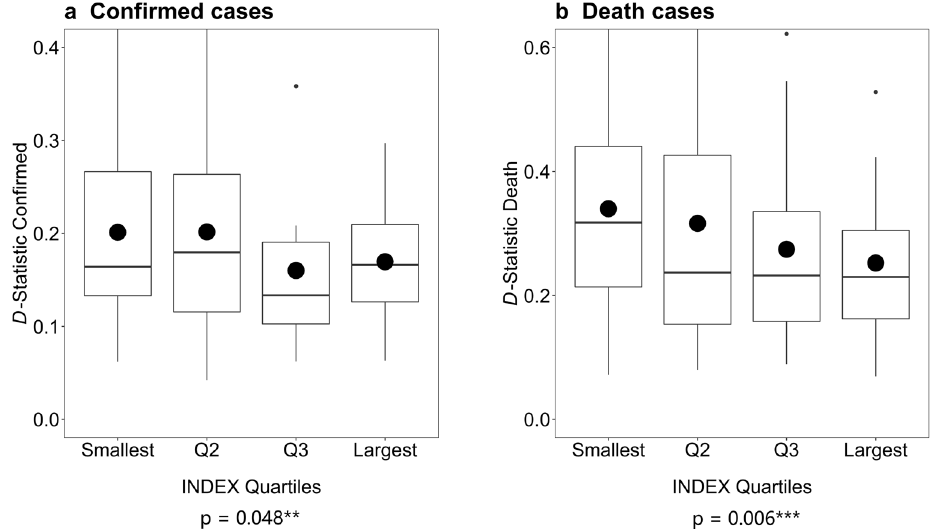
Figure 2. D -statistic and quartiles of the developmental index. The figure presents the boxplots of the D goodness-of-fit measure for the cumulative number of confirmed and death cases for the four quartiles of the developmental index. The unit of observation is a country. Smallest, Q2, Q3 and Largest represent the values partitioned by the 25%, 50%, and 75% quartiles of the developmental index. The boxplots represent 25%, 50%, and 75% quartiles of D . The dots represent the mean values. *** and ** indicate significance of the difference in means between the Smallest and the Largest quartile at the 1% and 5% level,